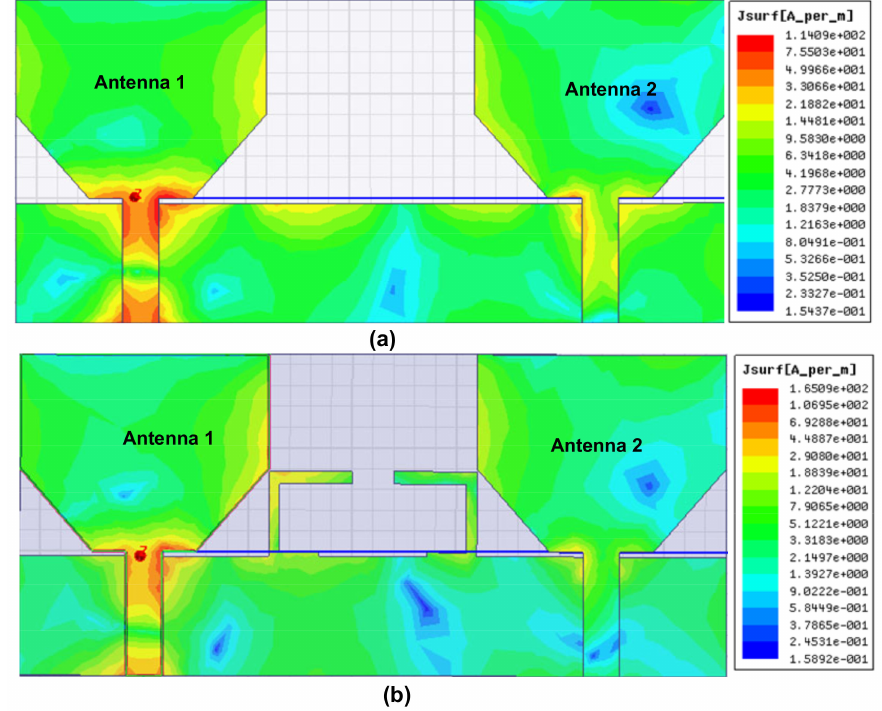
Figure 11. Surface current distribution at 6.85 GHz ( a ) without decoupling, ( b ) with MEBG decoupling